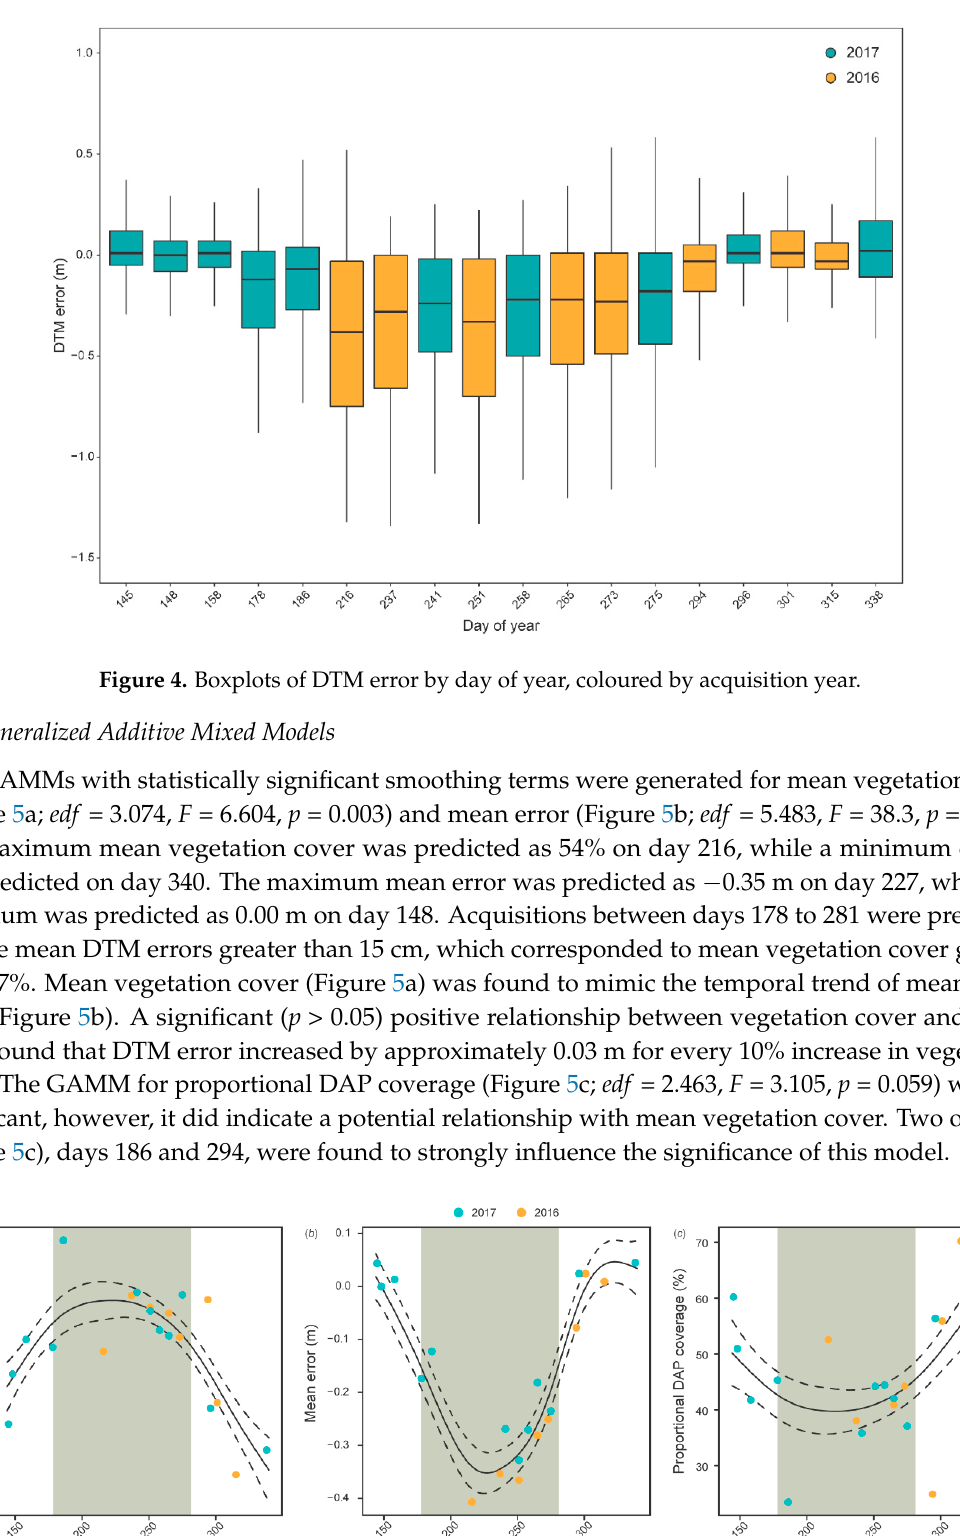
Figure 3. Visualized error (m) for each DAP-derived DTM listed by day of year relative to the reference ALS-derived DTM. Grey colour indicates the full extent of the reference DTM.